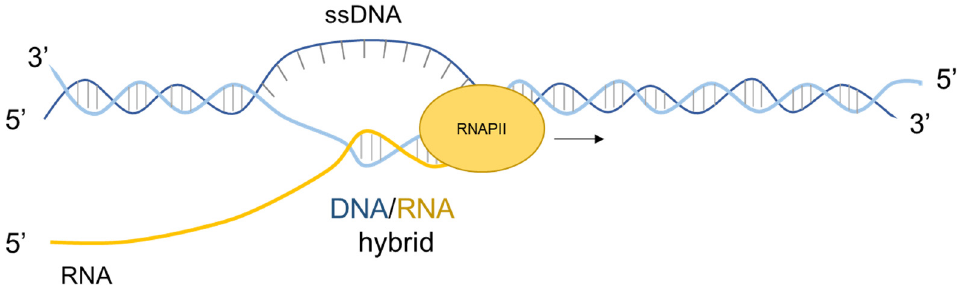
Figure 2. Schematic representation of the R-loop structure. An R-loop is a three-stranded nucleic acid structure composed by a DNA–RNA hybrid and a displaced non-template single-stranded DNA (ssDNA).